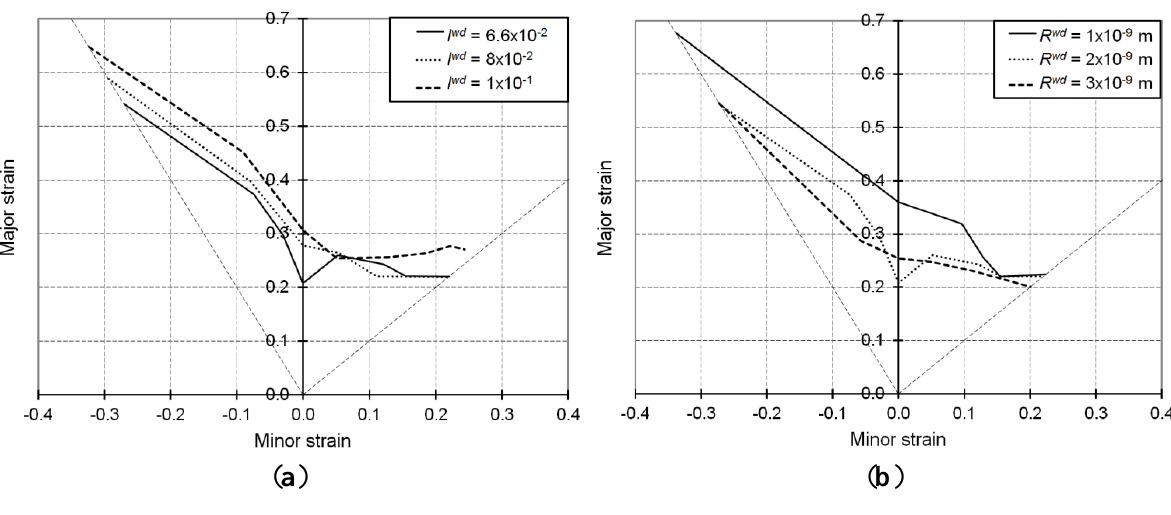
Figure 7. Simulated FLDs associated with linear loading paths for the IF – Ti single-phase steel as obtained with the Bifurcation–EPSC model: Effect of the model parameters associated with the intensity of dense dislocation